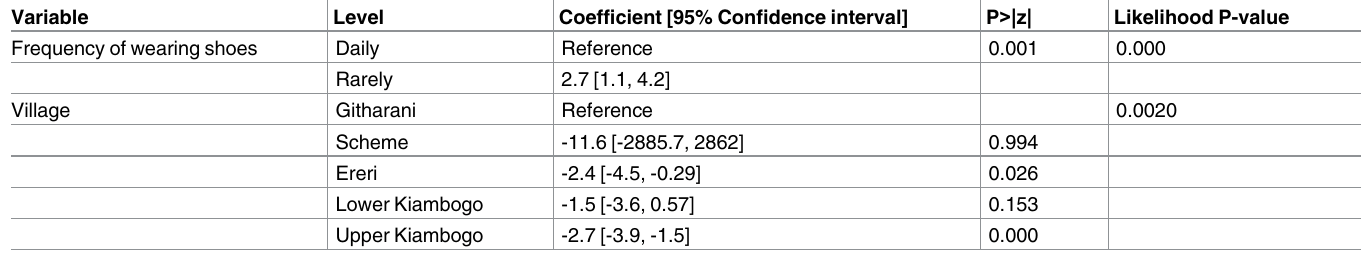
Table 7. Significant variables in the multivariable ( P (cid:20) 0.05) model assessing relationship between log of expected counts of Podoconiosis and risk factors.